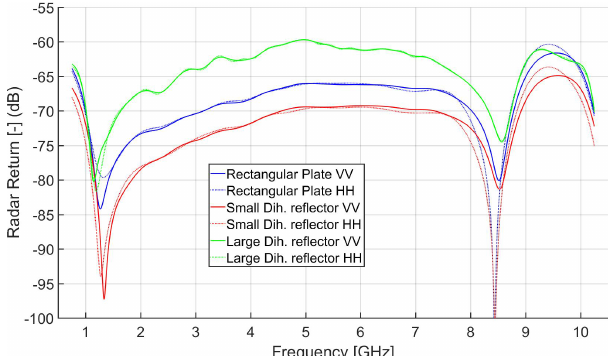
Figure E2. Measured radar returns of calibration standards for co- polarization E g0 . Solid lines are VV, and dotted lines are HH polar- 0